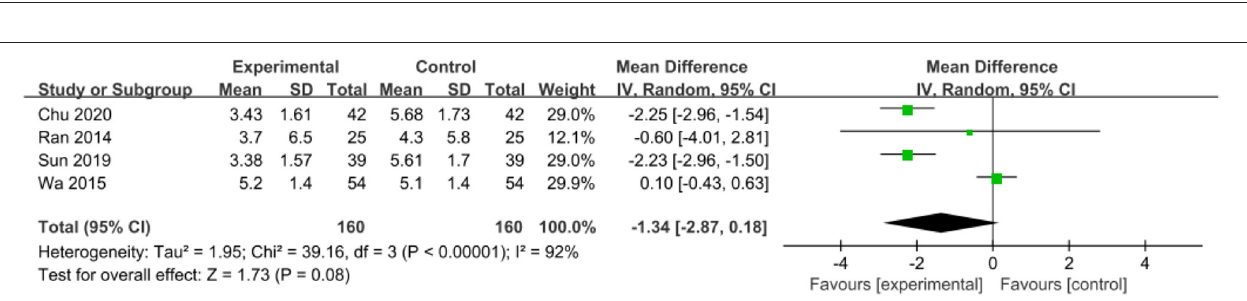
FIGURE 15 | Forest plots of BUN associated with experimental group (parenteral or enteral nutrition group supplemented with Gln) vs. control group (conventional nutrition group). I 2 tests and P are the criteria for the heterogeneity test, (cid:7) , pooled mean difference; — (cid:4) —, mean difference, and the edges of (cid:7) , 95%